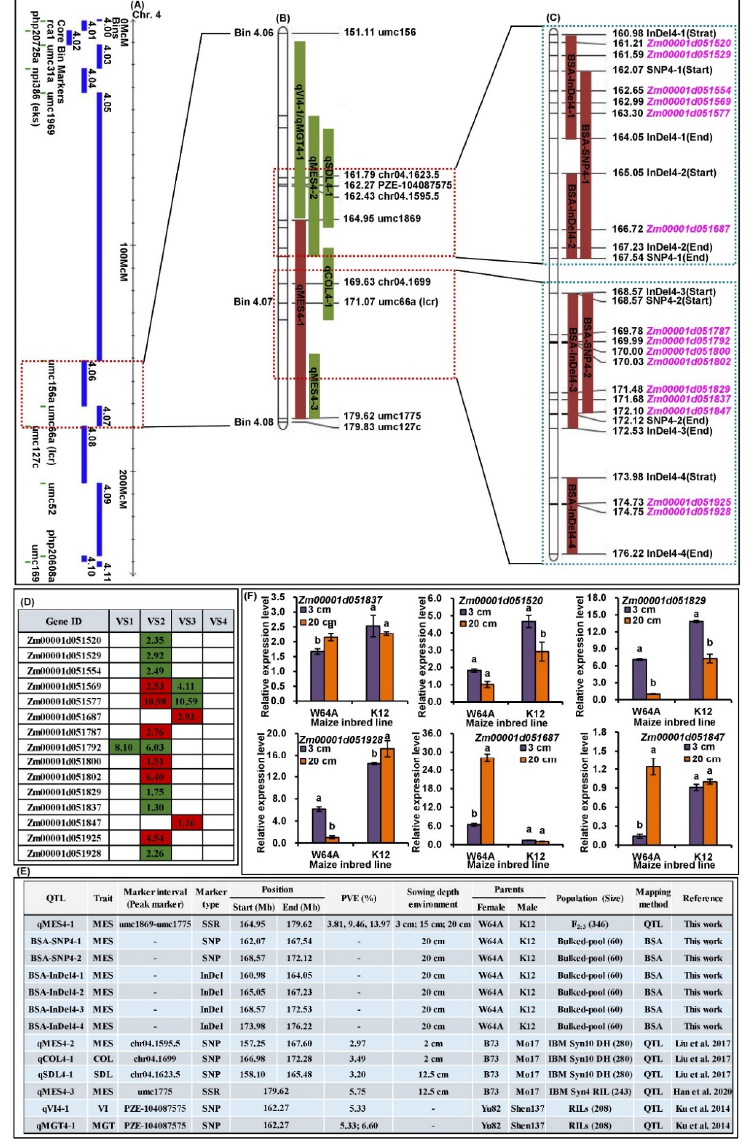
Figure 6. cQMES4 region and corresponding candidate genes information. ( A ) Distribution of different Bins on maize chromosome 4. ( B ) Physical map information of cQMES4 that contained multiple overlapped QTLs for mesocotyl length (MES), coleoptile length (COL), seedling length (SDL), vigor index (VI), and mean germination time (MGT). ( C ) Physical map information of cMES4 that including our six linked BSA regions and 15 identified candidate genes in cQMES4. ( D ) The expression patterns of 15 identified candidate genes in cQMES4 by RNA-sequencing; the red-box or green-box representing the corresponding gene was up-regulated or down-regulated, and the value in the box was the log2 fold-change of the corresponding gene. ( E ) Summary of all QTLs and linked BSA regions information in cQMES4 region from our work and previous studies. ( F ) Relative expression level of six candidate gens in W64A and K12 mesocotyls under 3 and 20 cm sowing environments; different lowercase letters with a single parent under different environment indicated a significant difference with p < 0.05